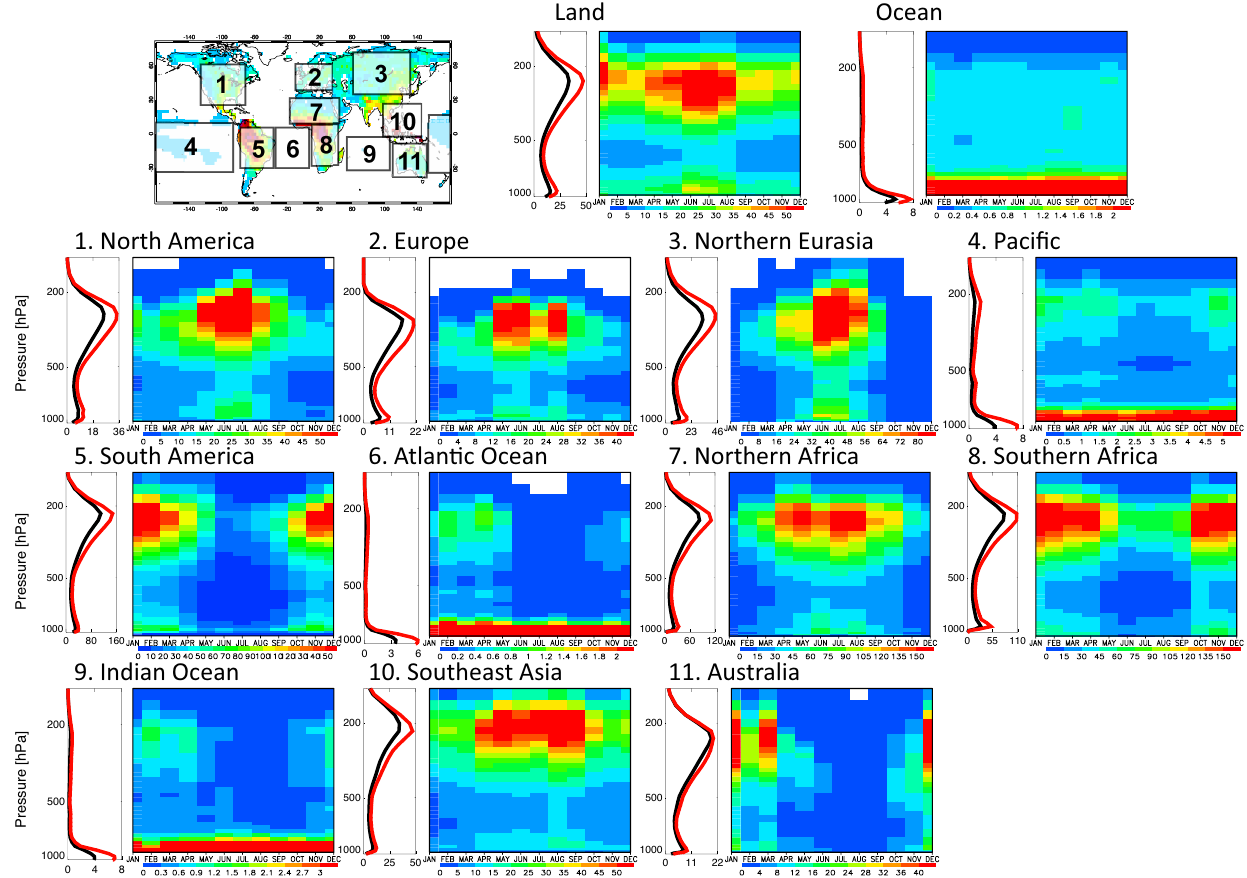
Fig. 8. Similar to Fig. 7, but shows for the vertical profile of the annual mean a priori (black) and a posteriori (red) LNO x sources (left panels) and the seasonal variation of the monthly mean vertical profile of the a posteriori LNO x source (right panels) in pptvday − 1 .